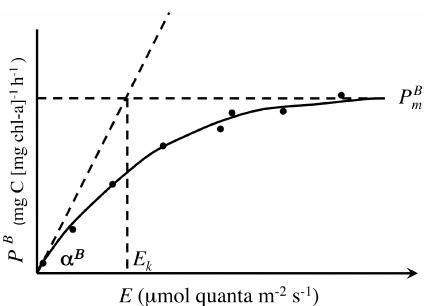
Figure 1. Photosynthesis–irradiance ( P - E ) curve showing the two biomass-normalised photophysiological parameters, the maximum photosynthetic rate P B m and the initial slope α B